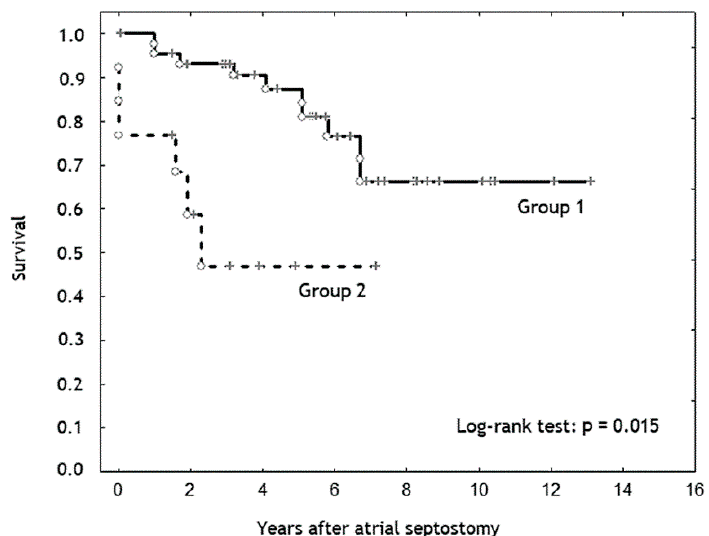
Figure 1. Kaplan–Meier survival curve. Patients from the “intermediate” risk group (Group 1) demonstrate significantly higher survival rate than patients from the “high” risk group (Group 2) ( p =